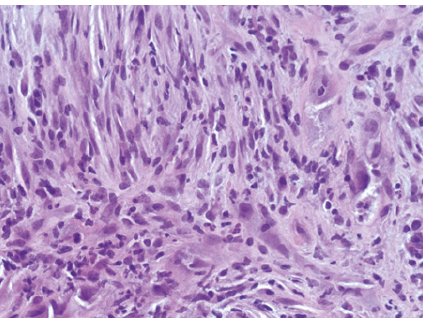
Figure 7: Smooth muscle actin immunohistochemistry, demon- strating reactivity in the mesenchymal component (200x original